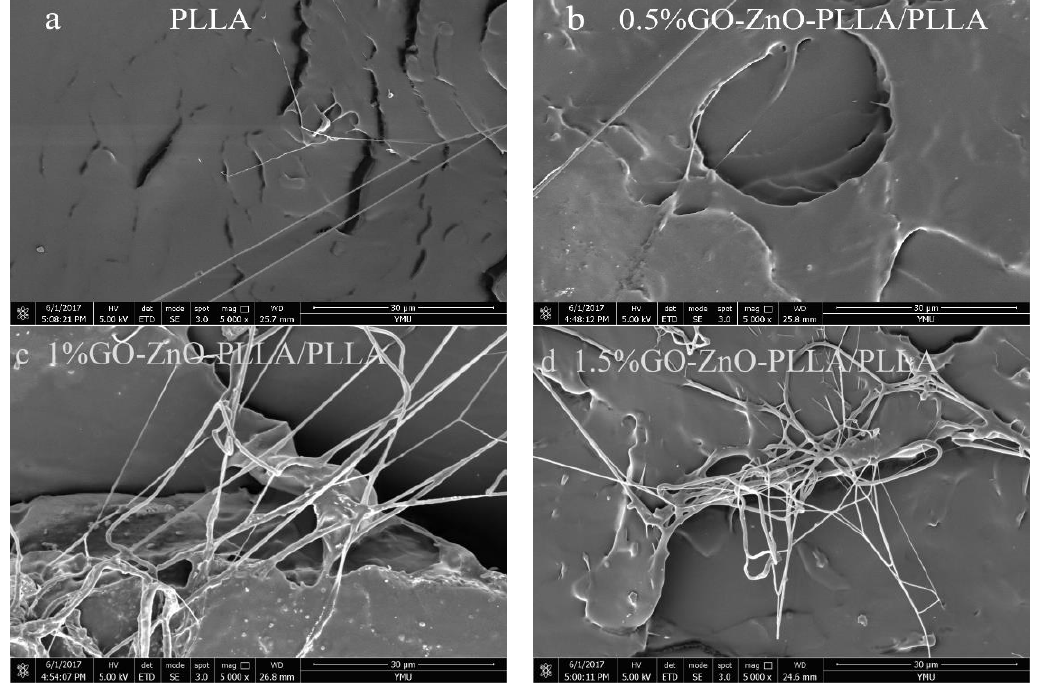
Figure 11. SEM (scanning electron microscopy) of fracture surfaces of PLLA and GO-ZnO-PLLA/PLLA composite films.